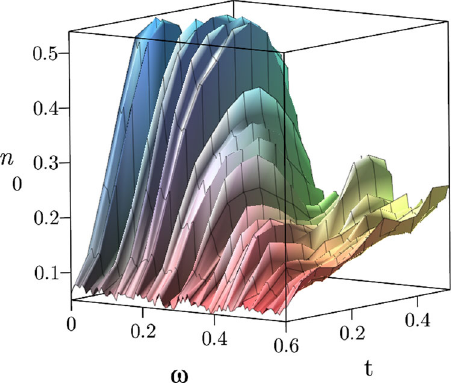
Fig. 1 Frequency scan of simulated time evolution for a single qubit. Scan of population of the 0 j i state ( n 0 ) as a function of simulated time t and frequency ω on the ibmq_armonk device. We initially prepare the 1 j i state and then apply 100 total gate sequences of exp ½(cid:2) i τ H (cid:3) , where the time step is τ ¼ 1 , the system Hamiltonian is H = ωσ z , ω ∈ (0, 0.6), and σ z is 3 de fi ned in Eq. (2). The time t is equal to the number of gates times τ multiplied by the scaling factor 0.015. The oscillatory behavior reveals non-Markovian effects with the oscillations becoming less pronounced at higher frequencies.